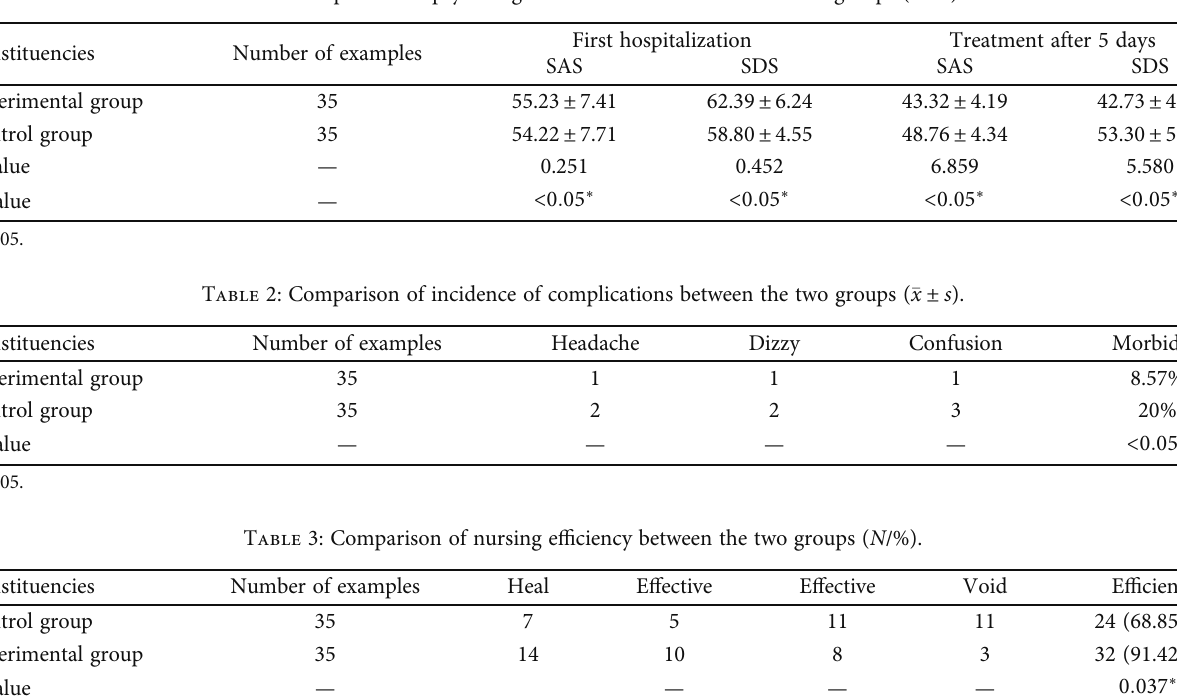
Table 1: Comparison of psychological status scores between the two groups ( (cid:1) x ± s ).